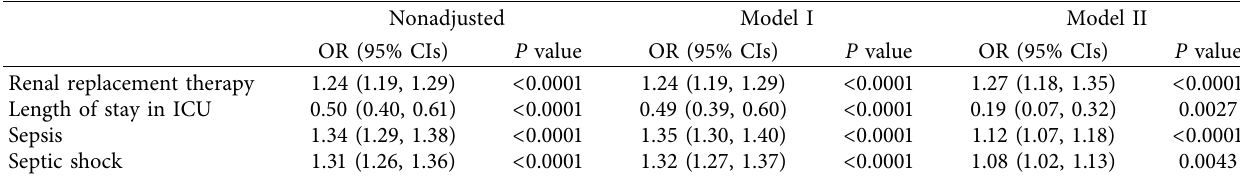
Table 3: ORs (95% CIs) for partial secondary outcomes across RA